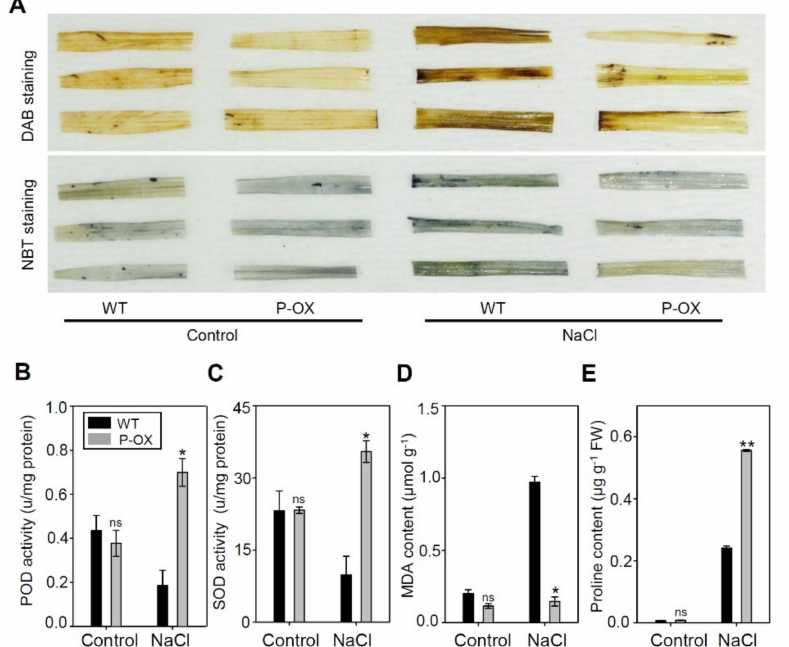
Figure 6. Histochemical staining and antioxidant activity in wild-type and transgenic rice plants under salt stress. ( A ) Detection of H 2 O 2 and O 2 − by DAB (upper panel) and NBT (bottom panel) staining, respectively, in WT and transgenic seedlings. Seven-day-old plants were grown in normal medium, treated with 0 or 150 mM NaCl for 14 days, and stained as indicated. ( B , C ) Antioxidant activity in WT and transgenic leaves. ( D , E ) MDA and proline content. POD, peroxidase. SOD, superoxide dismutase. MDA, malondialdehyde. All the experiments were performed with at least three biological replicates. OsAct11 was used as a control. Asterisks indicate a statistically significant di ff erence, as determined by Student’s t -test, (** p < 0.01, * p < 0.05). Photographs shown in A are representative images. DAB, 3,3 (cid:48) -diaminobenzidine; NBT, nitrotetrazolium blue chloride; MDA, malondialdehyde; ns, not